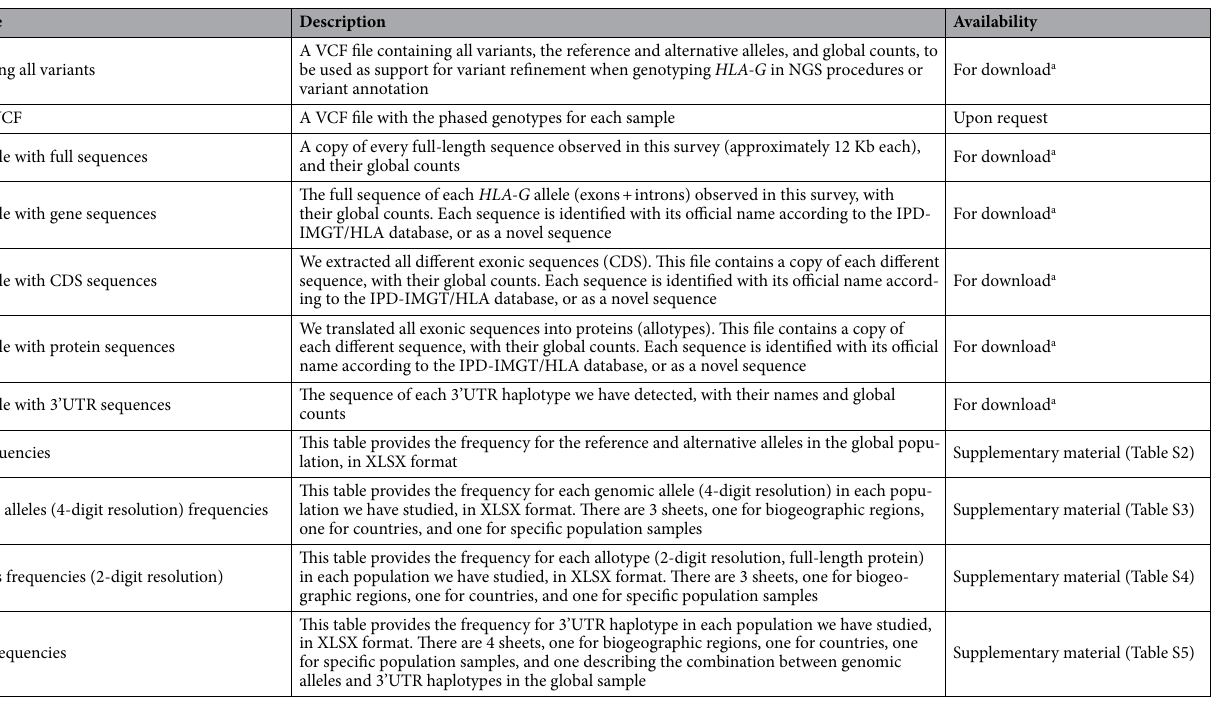
Table 1. Resources available for download or listed as supplementary material regarding the HLA-G gene and its polymorphisms. a Available for download in www. caste lli- lab. net/